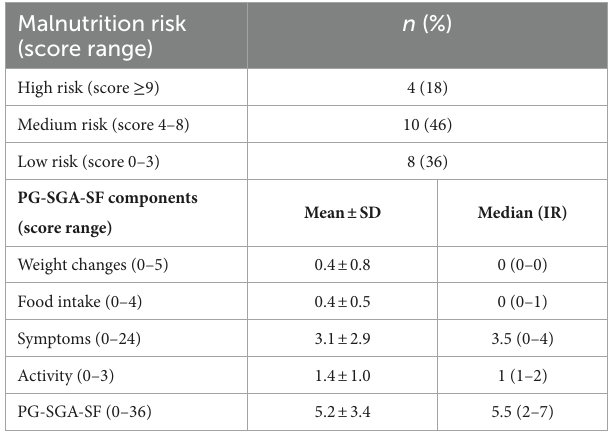
TABLE 11 Component scores and sum score for the Patient-Generated Subjective Global Assessment Short Form (PG-SGA-SF). Malnutrition risk (score range)